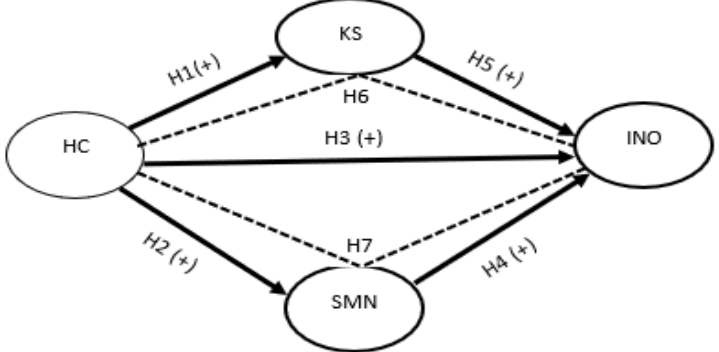
Figure 1. Conceptual Model. Notes: HC = Human Capital. SMN = Social Media Networking. KS = Knowledge Sharing. INO = Innovation.